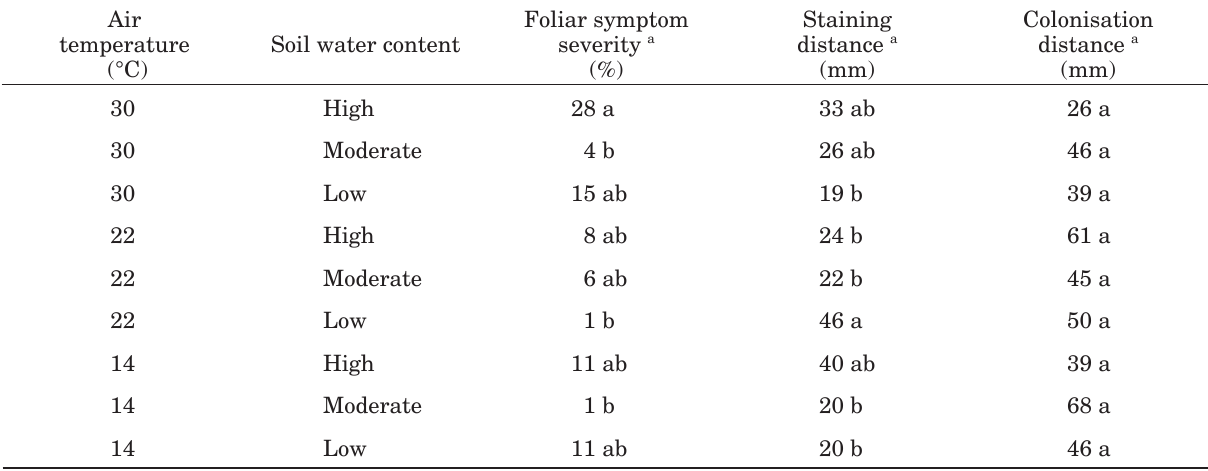
Table 2. Severity of foliar symptoms, total distance of staining and mycelial colonisation of 1-year-old grapevines ( Vi- tis vinifera cv. Red Grenache) above and below the point of inoculation with Eutypa lata and incubated in controlled environment rooms maintained at 14°C, 22°C or 30°C with high (20 – 40%), moderate (10 – 25%) or low (5 – 20%) soil water content for 7 months. Nine replications per